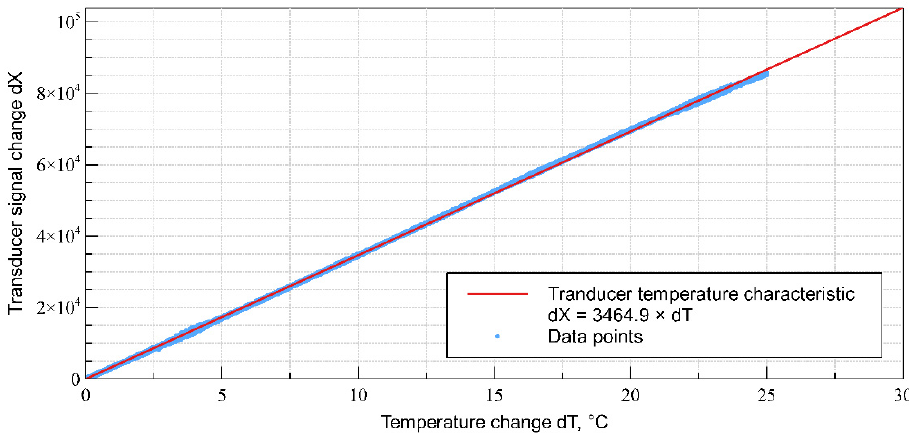
Figure 9. Determination of temperature influence on transducer signal.